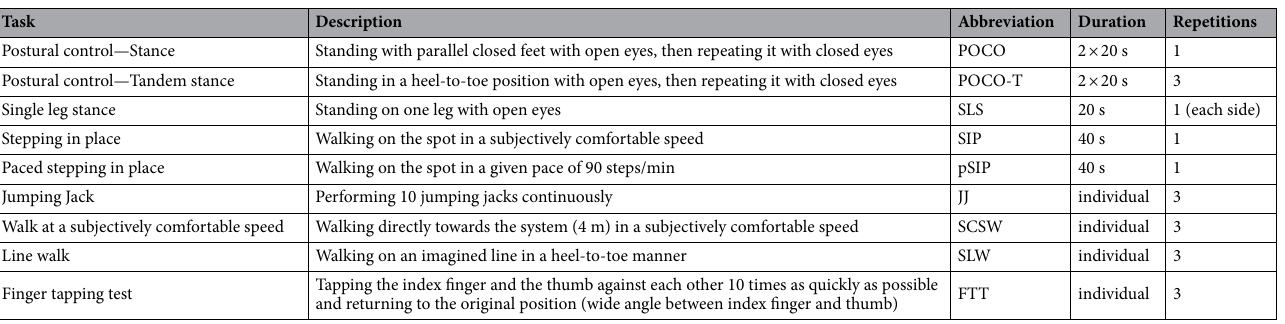
Table 1. Description of the nine Movement